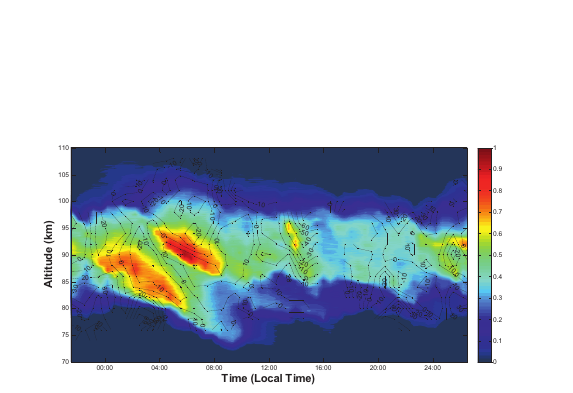
Fig. 3 Relative sodium density and simultaneous zonal wind measured by Radar. Sodium density are shown with color mapping scaled from 0 to 1, winds are shown as contours with black lines. The formation of metal atomic layers is considered to be controlled by the interaction of meteoric ablation injection, dynamical transport and processes.